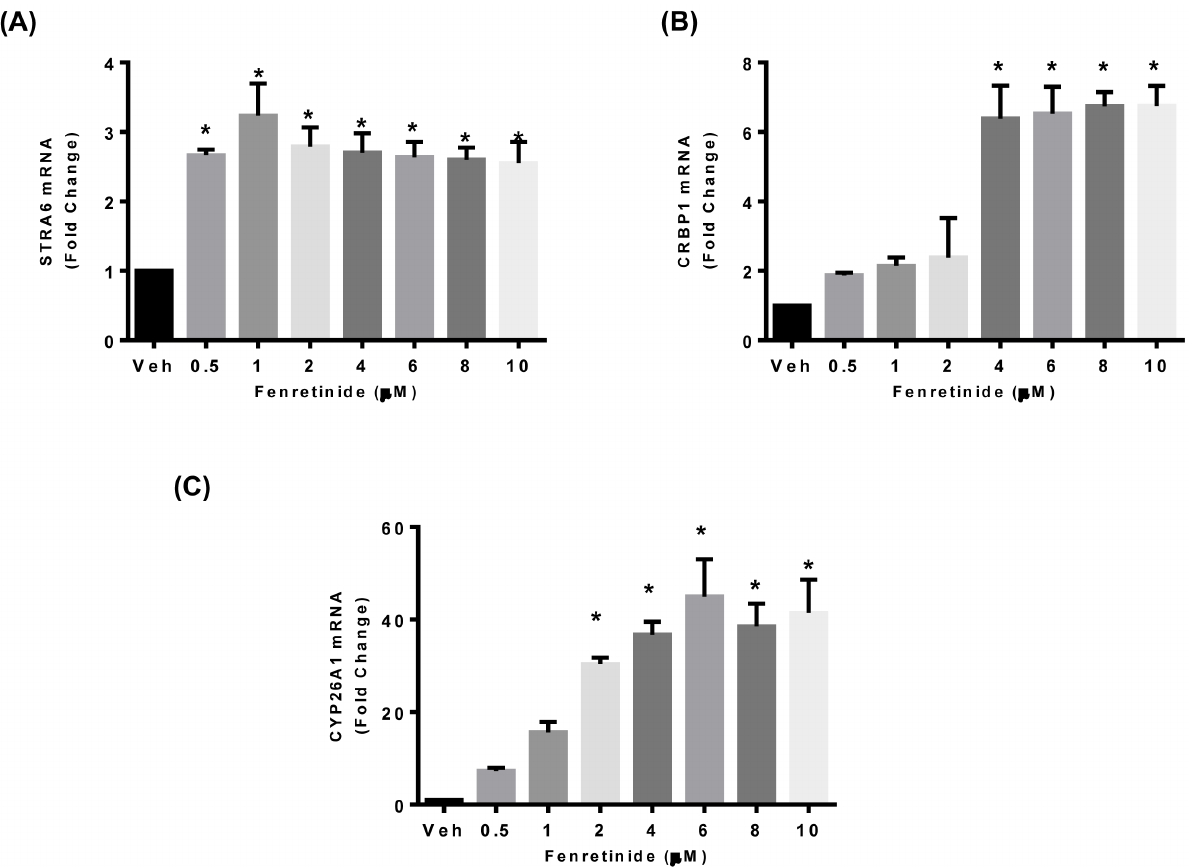
Figure 2. Fenretinide increases retinol uptake genes expression in endometrial cancer Ishikawa cells (A–C). Total RNA was isolated from Ishikawa cells treated with DMSO (Veh) or 0.25–10 m M fenretinide for 24 h and the expression of genes involved in retinol uptake was measured by RT-qPCR. Data are presented as fold change in relative mRNA expression of fenretinide treated cells from DMSO treated samples cells and represent the mean 6 SEM of 3 independent experiments. An asterisk indicates a significant (* P , 0.05) increase in mRNA expression of ( A ) STRA6, ( B ) CRBP1 and ( C ) CYP26A1 genes in Ishikawa cells treated with fenretinide as compared to DMSO treated group.